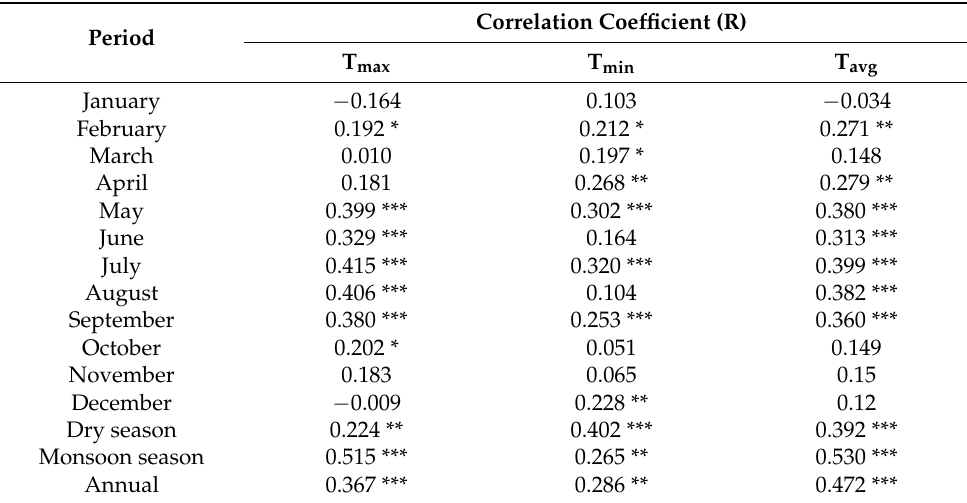
Table 2. MK significance levels in trends of monthly, seasonal and annual temperatures (1978–2017) at